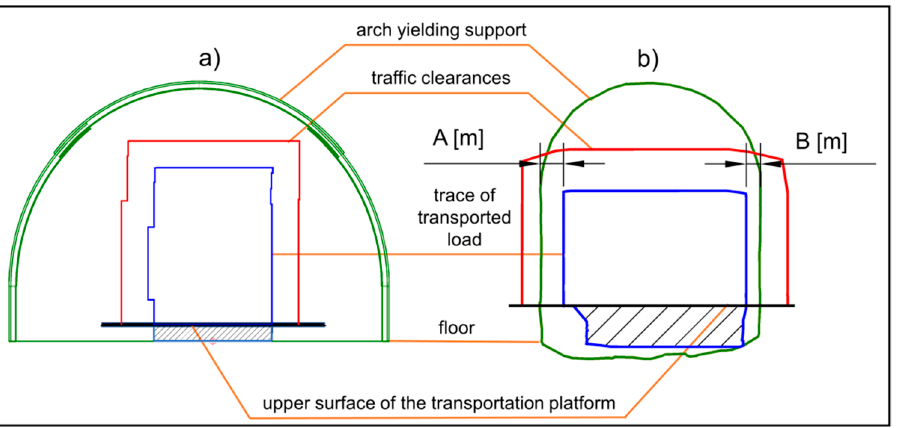
Figure 6. Examples of cross-sections of underground working: collision-free transport ( a ), transport with collision risk occurrence ( b ).